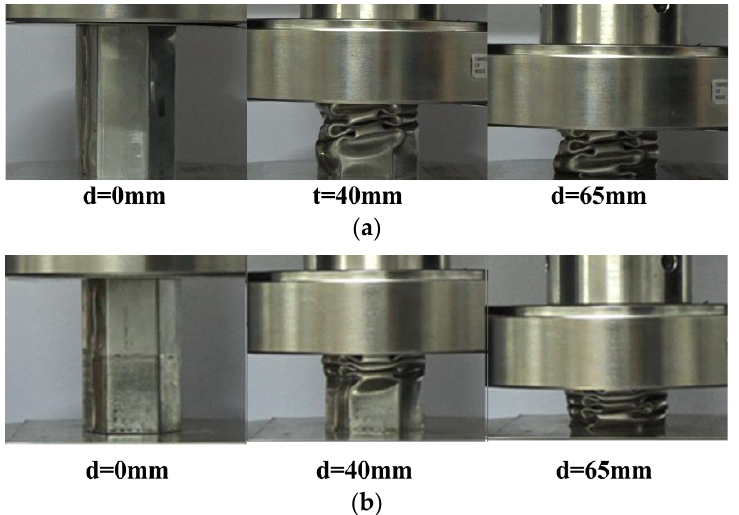
Table 3. Energy absorption parameters of empty tubes.